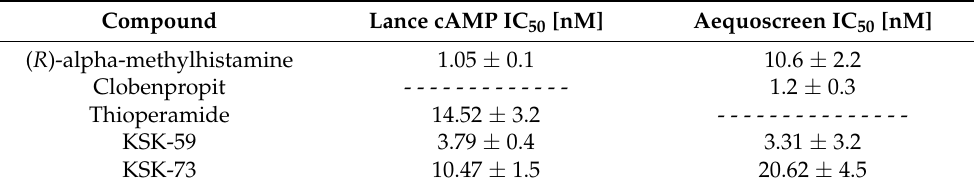
The IC 50 values for antagonist dose-response with reference agonist ((R)-alpha- methylhistamine) at a final concentration equivalent to the EC 80 . Obtained by two methods Lance cAMP and